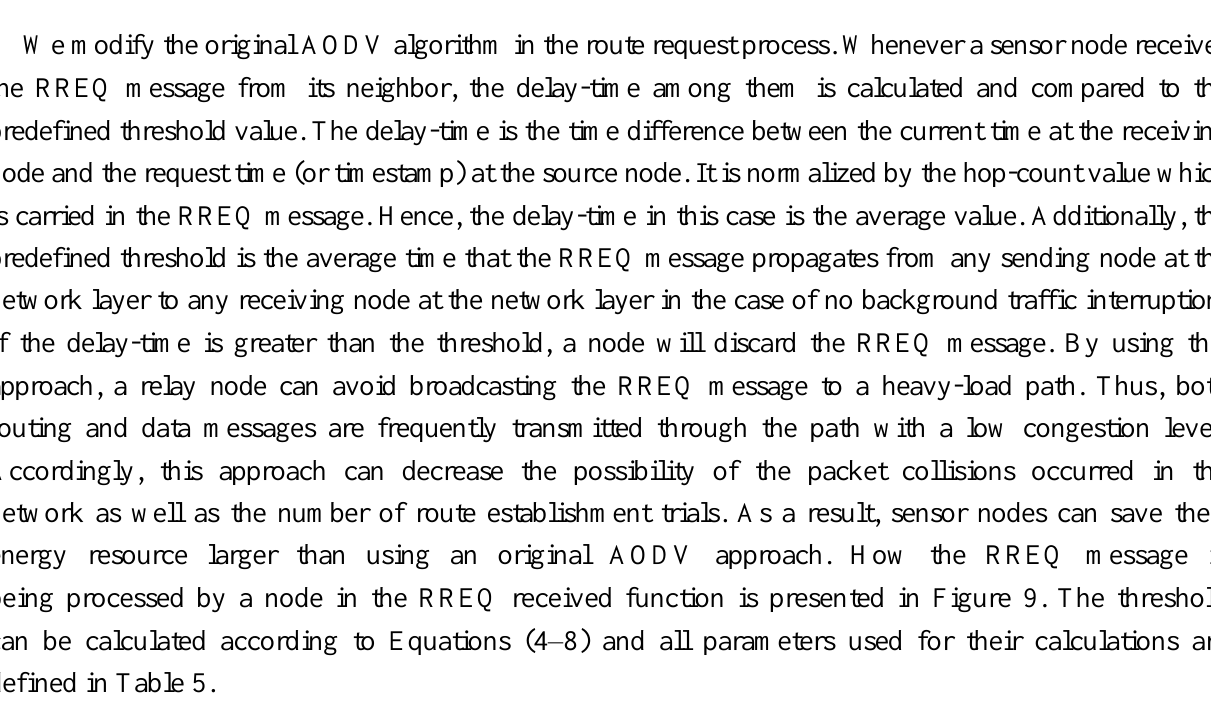
Figure 9. The pseudo code for the RREQ received function. This operation does not require any change in the RREQ message format; therefore, it is able to collaborate with